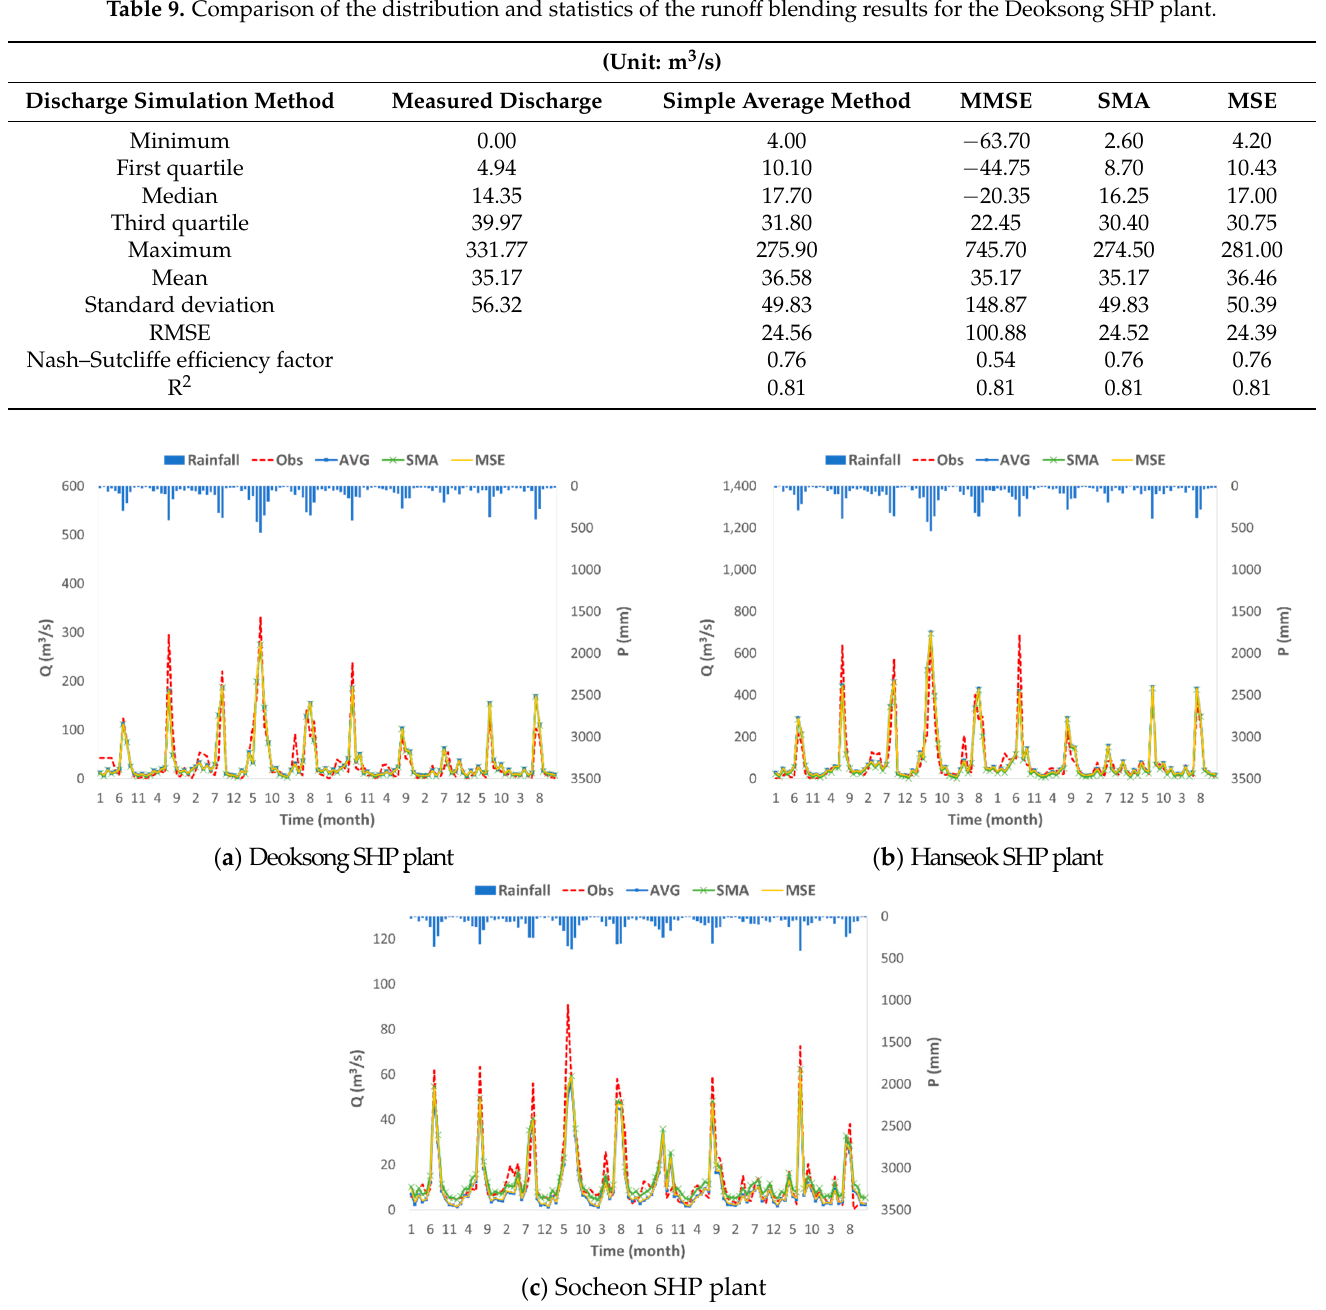
Figure 5. Comparison of the runoff blending results. The comparison of the measured discharge values with the runoff results obtained by applying the blending techniques to the simulated discharge values in the Saigokcheon junction basin where the Hanseok SHP plant is located are shown in Table 10. The results of the MMSE technique were excluded from the analysis because of the negative discharge values. Similar to the results of the Jeongseon basin, the results of the three blending techniques, except for the MMSE technique, showed a smaller RMSE value and larger Nash–Sutcliffe efficiency factor and R 2 than the results of the individual models. The time series graph drawn by excluding the result of applying the MMSE technique (Figure 5b) shows that all the values were similar to the measured discharge values, except for some underestimated